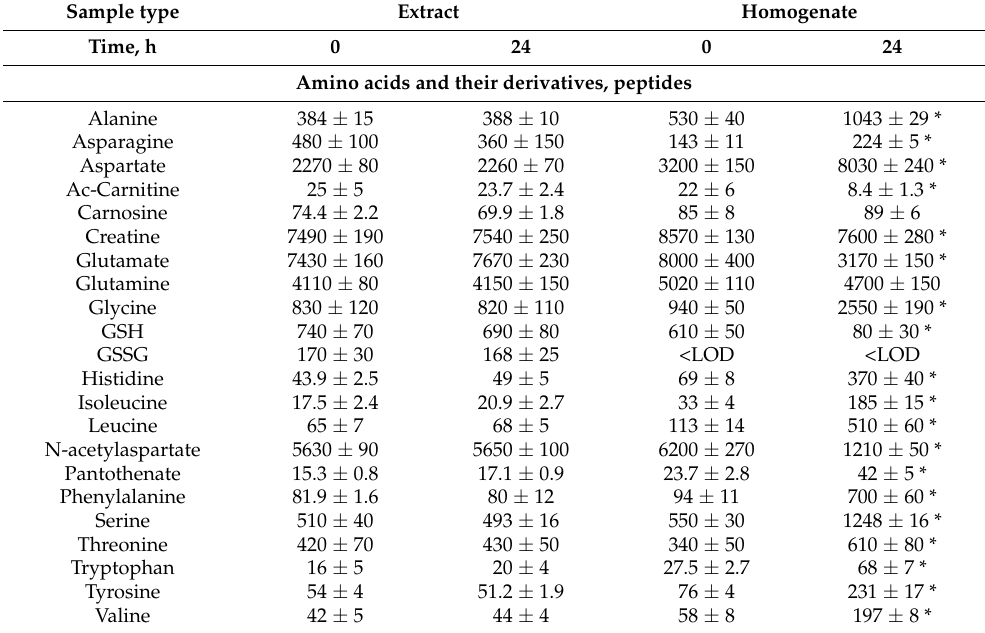
Table 2. Concentrations of metabolites (in units of nmol/g) in extracts and homogenates of the rat brain at zero time and after 24 h of incubation at 4 °C.